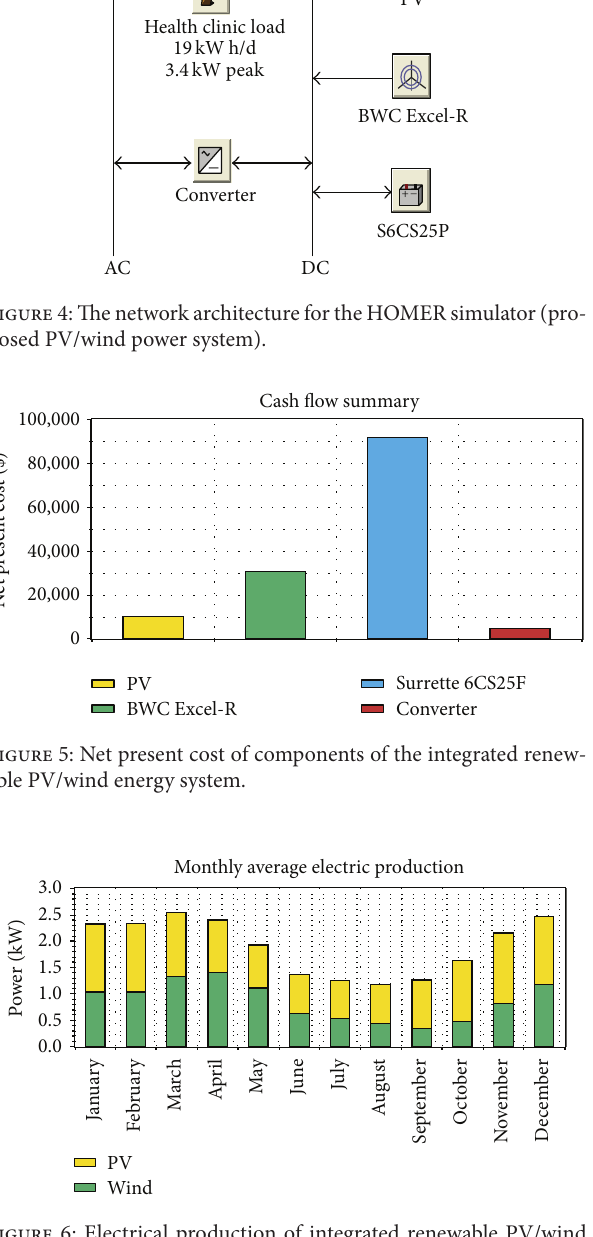
Figure 6: Electrical production of integrated renewable PV/wind energy system.